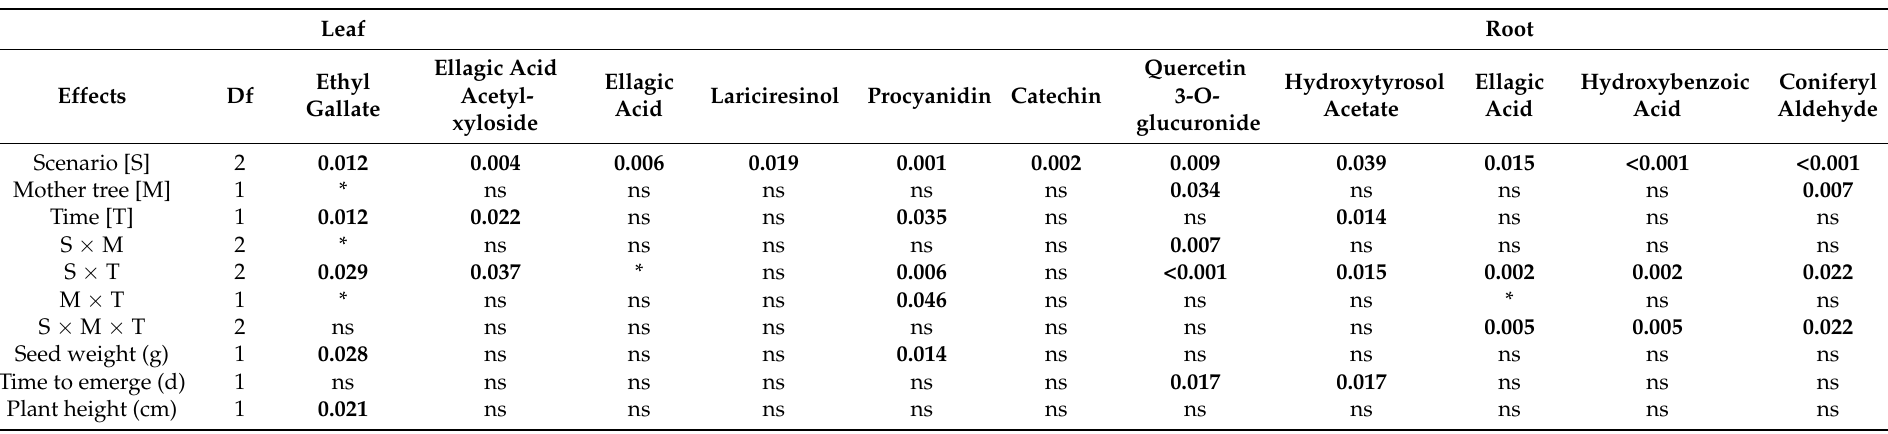
Table 2. Results of general linear models for analyses of chemical changes in seedlings of two Castanea sativa mother trees in response to warming scenarios. Significant p -values are indicated in bold ( p < 0.05), asterisks indicate marginally significant differences ( p < 0.10), and ns indicates non-significant result.